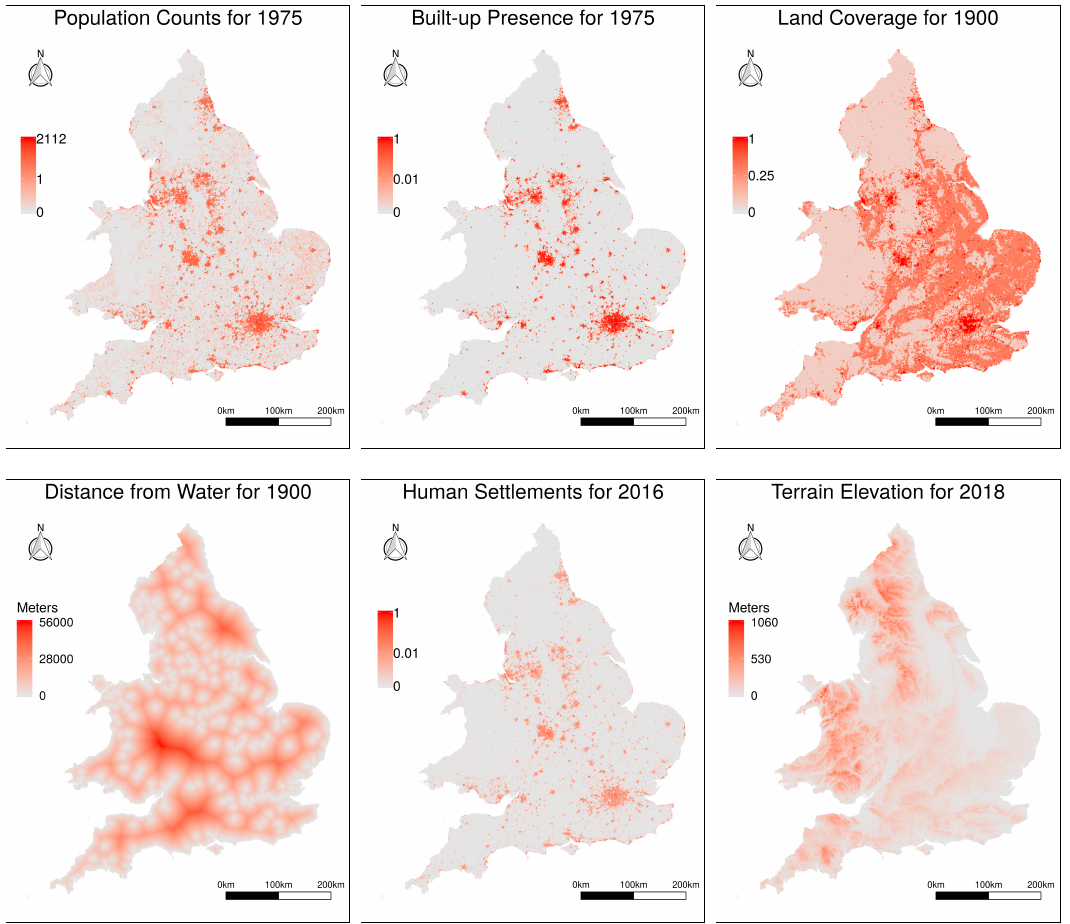
Figure 3. Map representations for the ancillary sources of